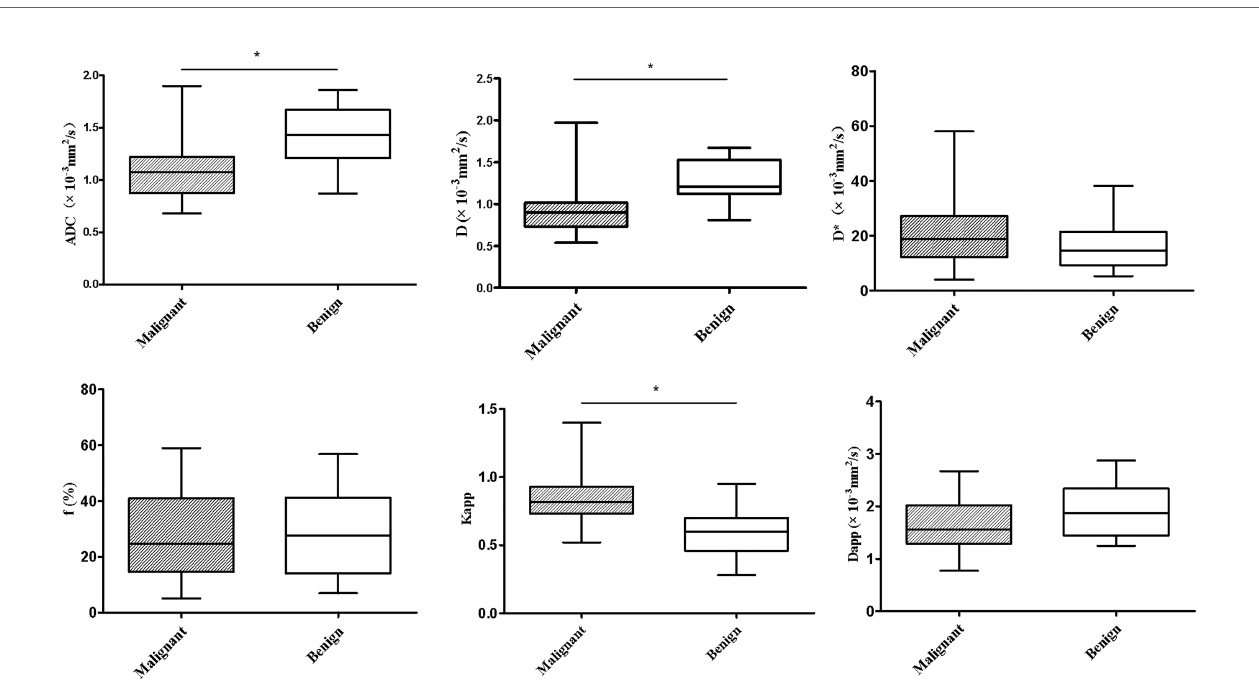
FIGURE 1 | Whiskers boxplots of ADC, D, D*, f, Kapp, Dapp values of malignant and benign lung lesions. *p <